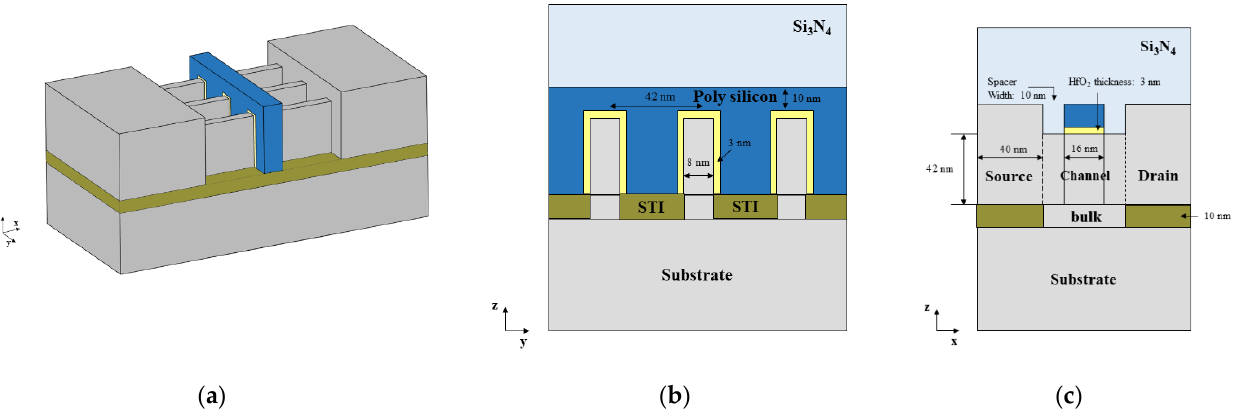
Figure 1. ( a ) The 3D schematics of the 14 nm technology node n-type FinFET [33], ( b ) the cross section perpendicular to the channel (y-z plane) [33], and ( c ) along the channel (x-z plane) of the FinFET [33].